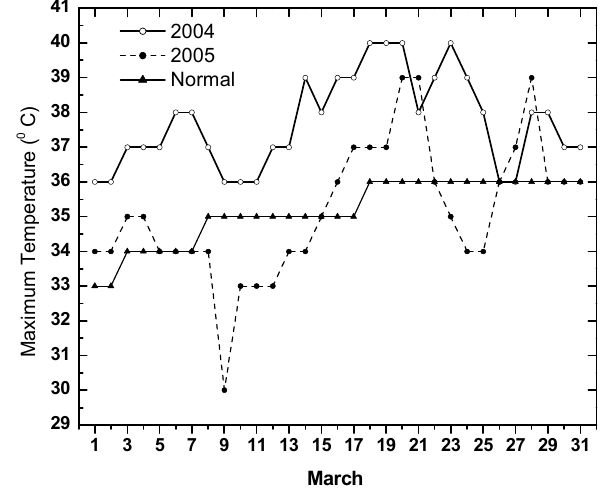
Fig. 3. Day-to-day variation of maximum surface temperature over Pune during March 2004 (open circle) and March 2005 (filled cir- cle). The line connected by triangles shows the climatological mean value for March.